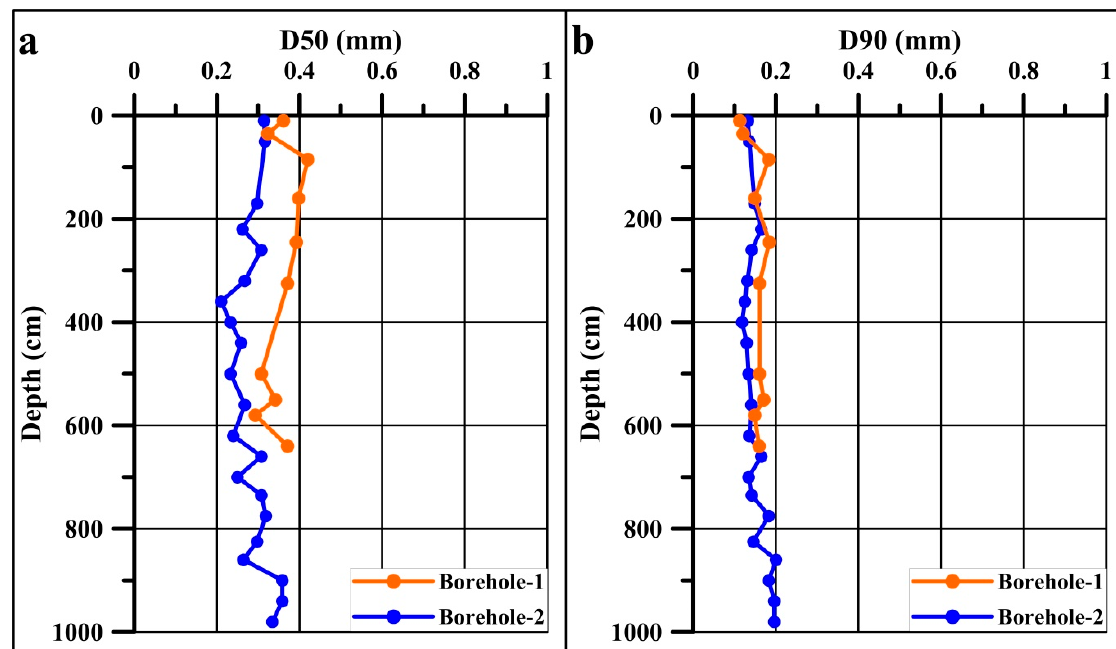
Figure 8. ( a ) D50 and ( b ) D90 of grain size distribution of the two boreholes.